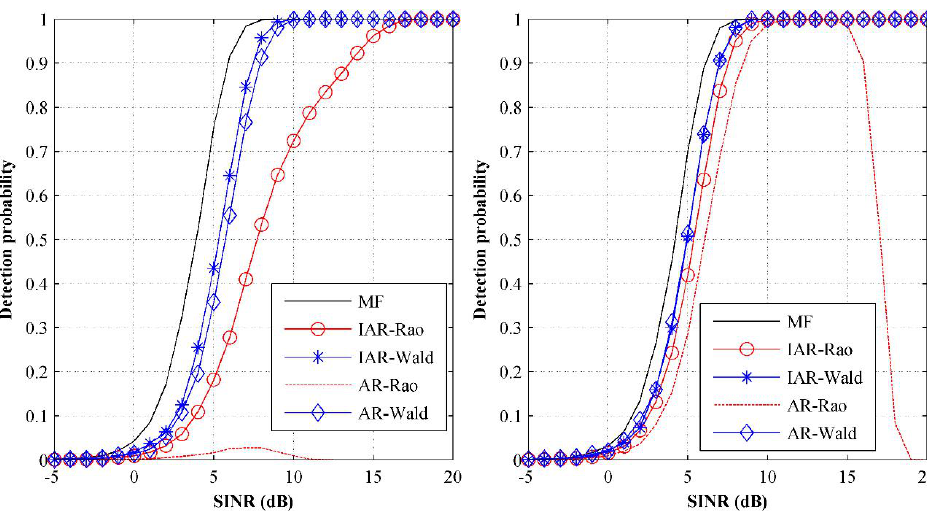
Figure 2. P d versus SINR of the MF, of the IAR-Rao, of the IAR-Wald, of the AR-Rao, and of the AR- Wald for L = 8, K = 3 and various N . ( left ) Detection performances while setting N = 8; ( right ) detection performances while setting N =